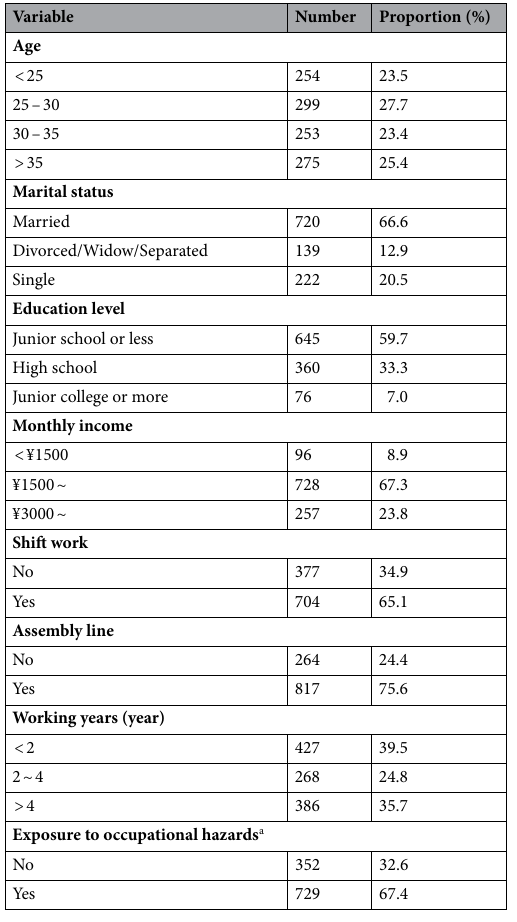
Table 1. Demographic and working characteristics of participants ( n = 1081). a Occupational hazard is a hazard experienced in the workplace; it can encompass many types of hazards, including chemical hazards, biological hazards (biohazards), psychosocial hazards, and physical